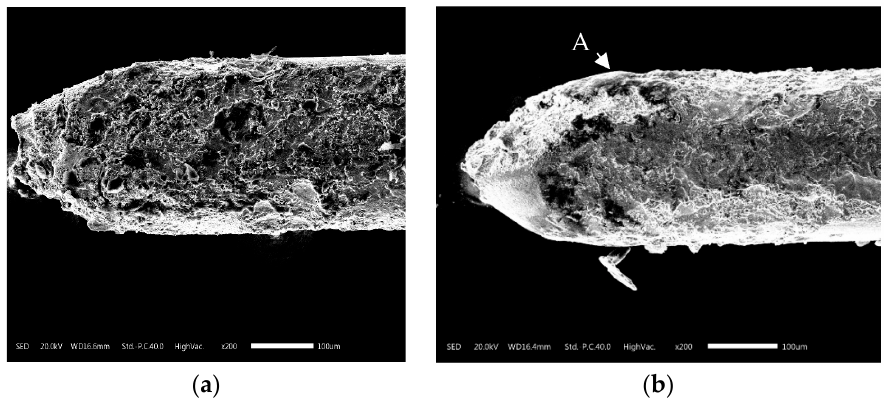
Figure 11 . SEM photographs of wire surface . ( a ) Wire surface with USV - WEDM; ( b ) Wire surface with Figure 11. SEM photographs of wire surface. ( a ) Wire surface with USV-WEDM; ( b ) Wire surface WEDM . with WEDM.